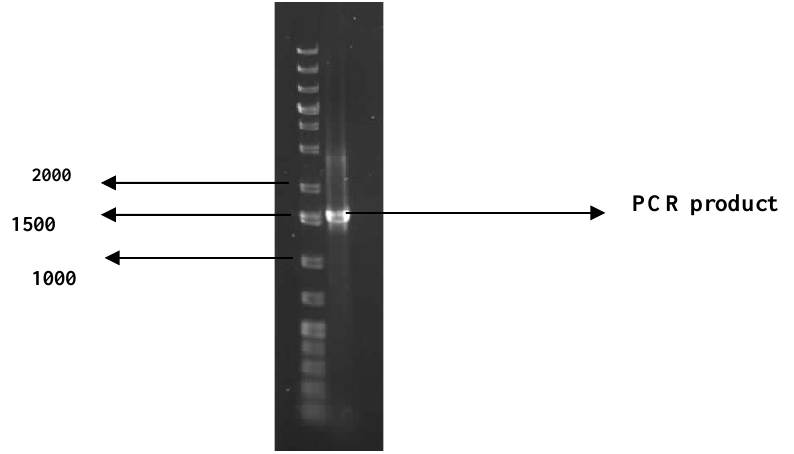
Figure 1. PCR product of the 16S rDNA of the test bacterium in 1% agarose gel electrophoresis. The first lane is DNA marker; while the second lane is the PCR